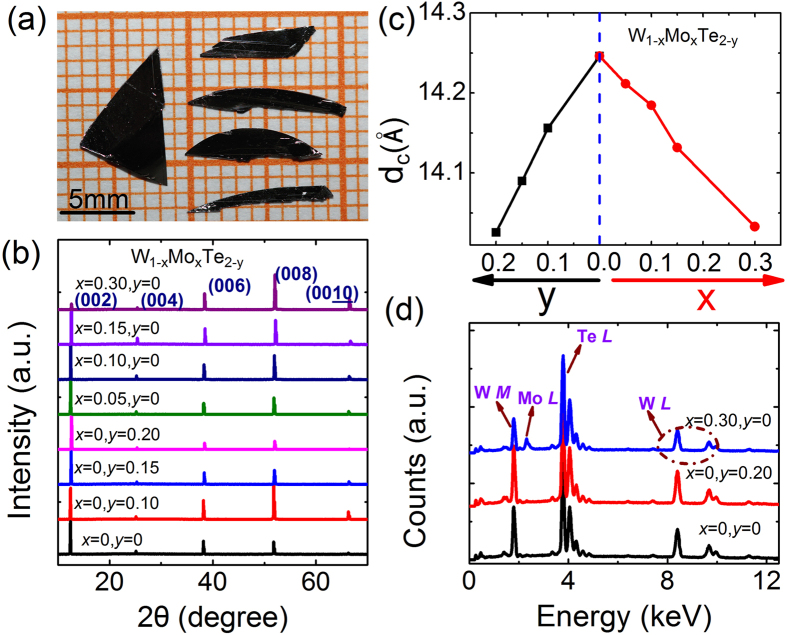
(a) The representative optical micrograph of the as-grown W1−xMoxTe2−y single crystals. (b) The XRD patterns of the single crystal W1−xMoxTe2−y samples. (c) The c-axis lattice parameter dc as a function of Mo-substituting level x and non-stoichiometric level y, respectively. (d) The EDS spectra of three representative samples (WTe2, WTe1.80 and W0.7Mo0.3Te2).